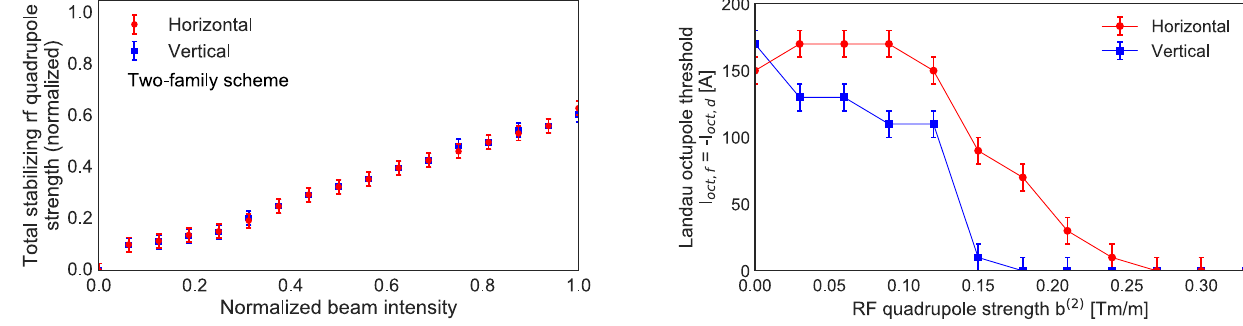
FIG. 16. P y HEADTAIL tracking simulations showing the com- bined stabilizing effect from LHC Landau octupoles and an rf quadrupole in the